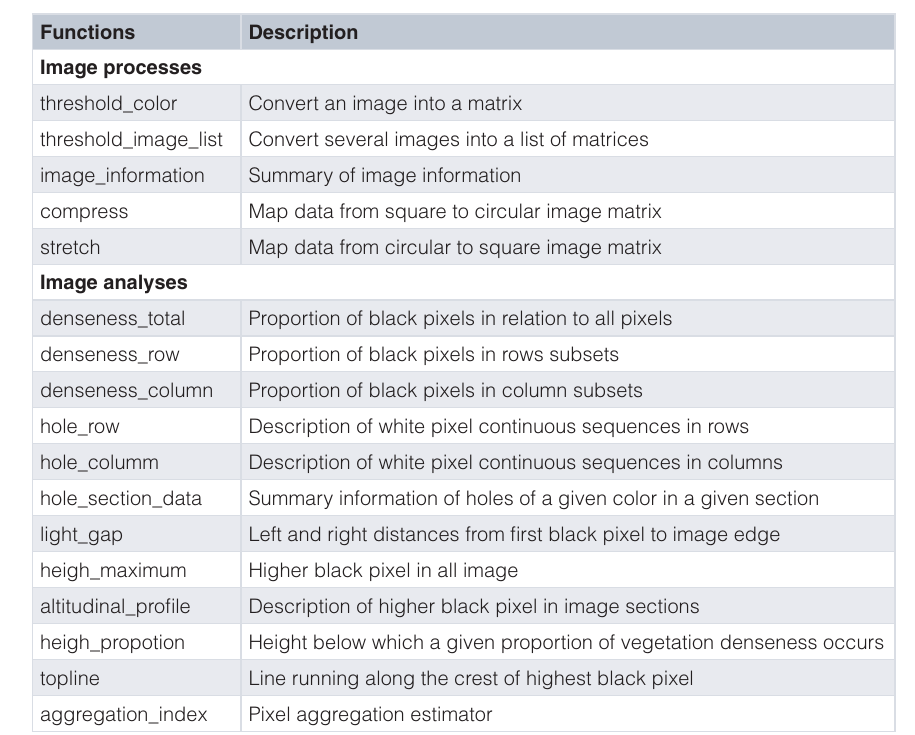
Table 1. Main functions of the bwimage